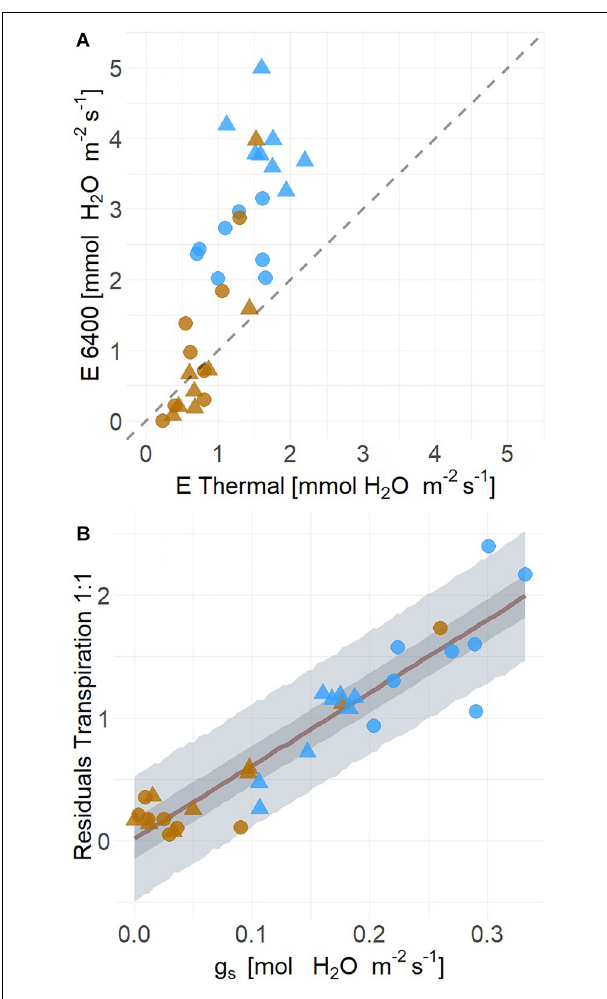
FIGURE 8 | Transpiration ( E ) estimated from leaf level energy balance using infrared radiometer data are lower than gas exchange measurements (LiCor 6400XT) under high transpiration rates in well-watered (blue) than droughted conditions (A) for both POTR (triangle) and PIPO (circle). Across both species and treatments, (B) the residual distance from the measured and estimated transpiration rates (i.e., 1:1 line) are explained by leaf-level stomatal conductance ( g s ) (Mean R 2 = 0.86). Maximum likelihood estimate is represented in red along with the 50% (dark gray) and 94% (light gray) creditable